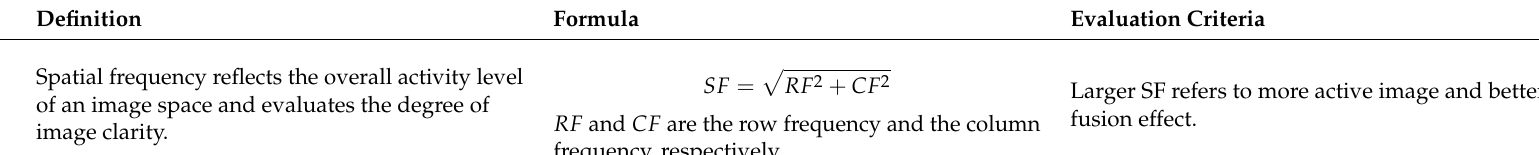
Table 1. Objective evaluation principle